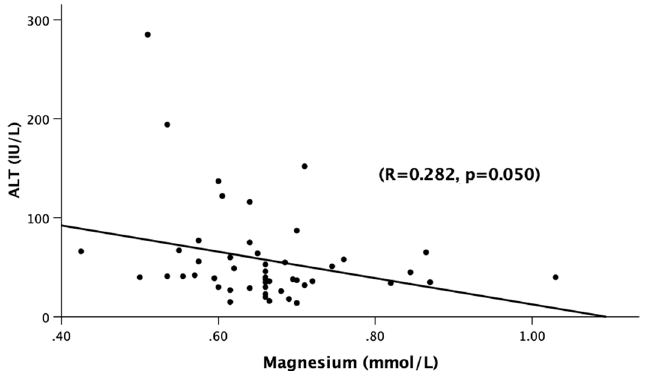
Figure 2. Association of serum magnesium levels (mmol/L) and ALT (IU/L) among all of the alco- holic hepatitis patients (Gr.1, Gr.2, Gr.3). Statistical significance was set at p < 0.05. The correlational coefficient (R) is provided.